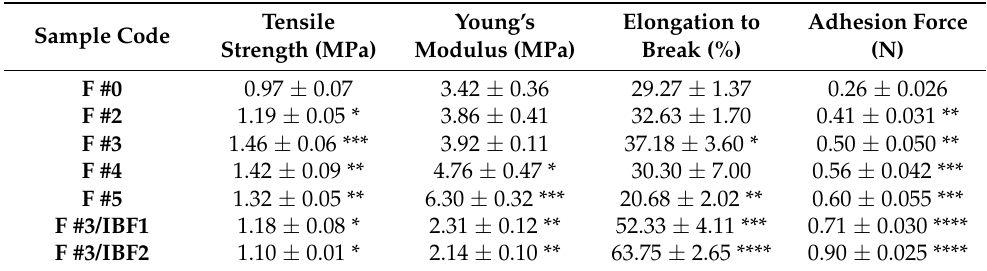
Figure 7. Stress−strain curves of PVA /OxCS and composite PVA/OxCS-Ag films without and with ibuprofen. Table 2. Mechanical properties of pure, unloaded and ibuprofen-loaded composite PVA/OxCS-Ag films.